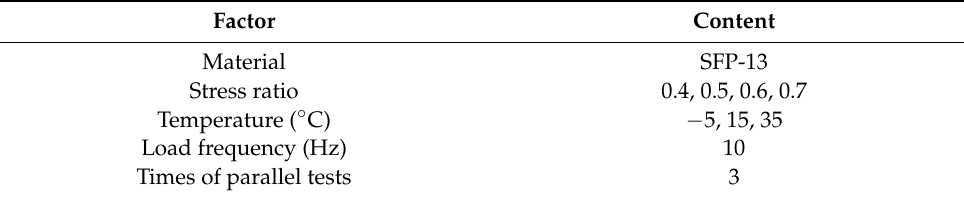
Table 4. Scheme of SCB fatigue